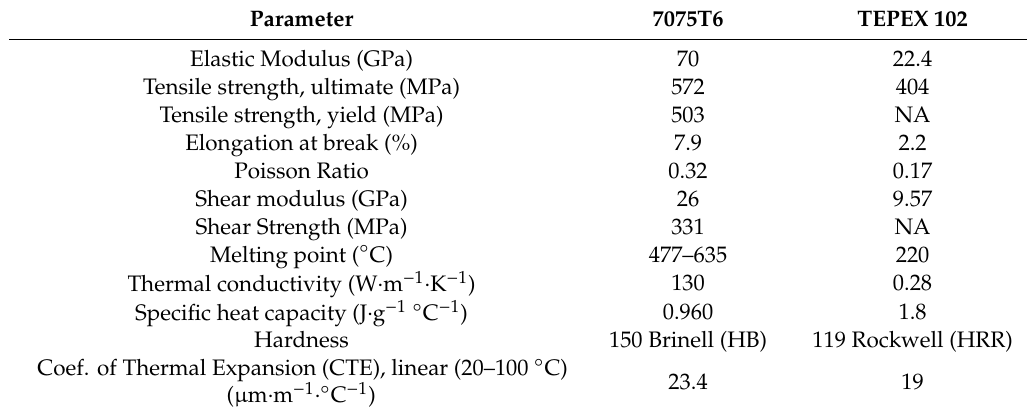
Table 2. Physical and thermal properties